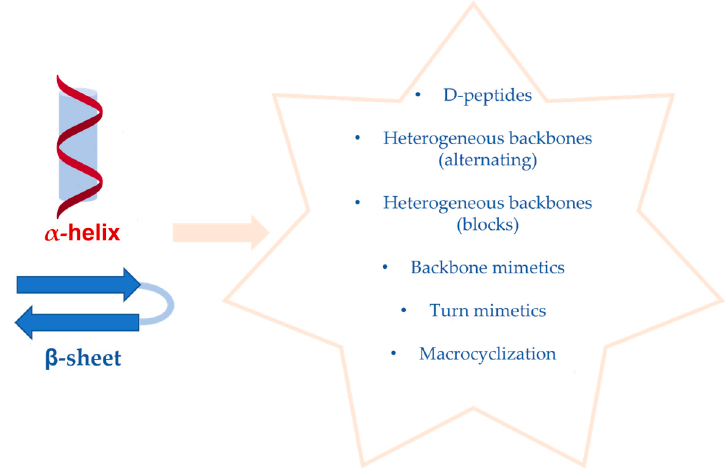
Figure 1. Structural diversity of foldamers.